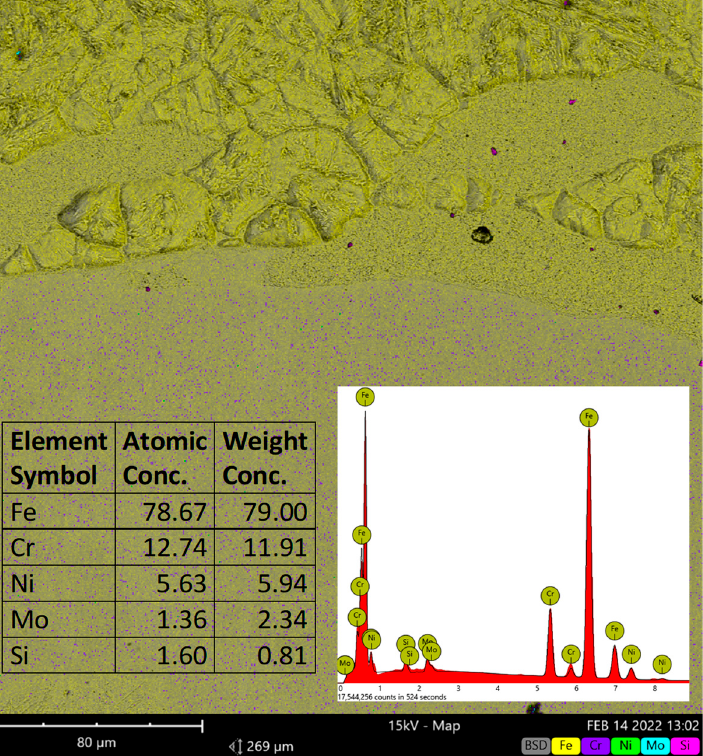
Figure 14. The chemical composition of the joint area (sample after direct connection).